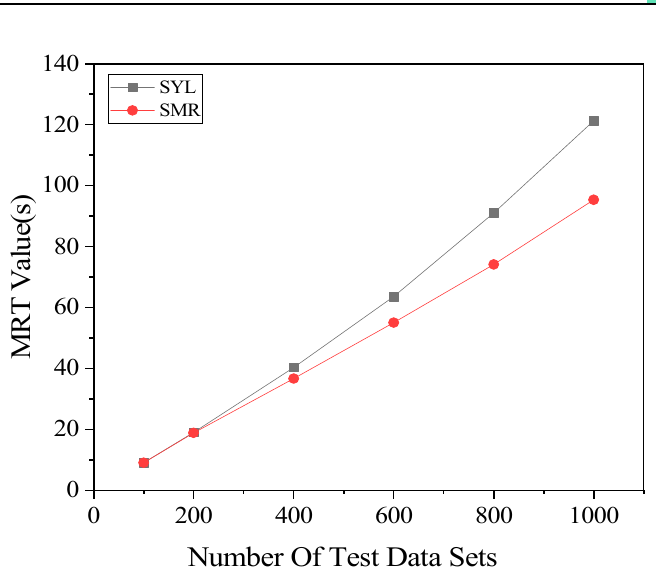
Figure 10. Change trend of MRT with data volume.